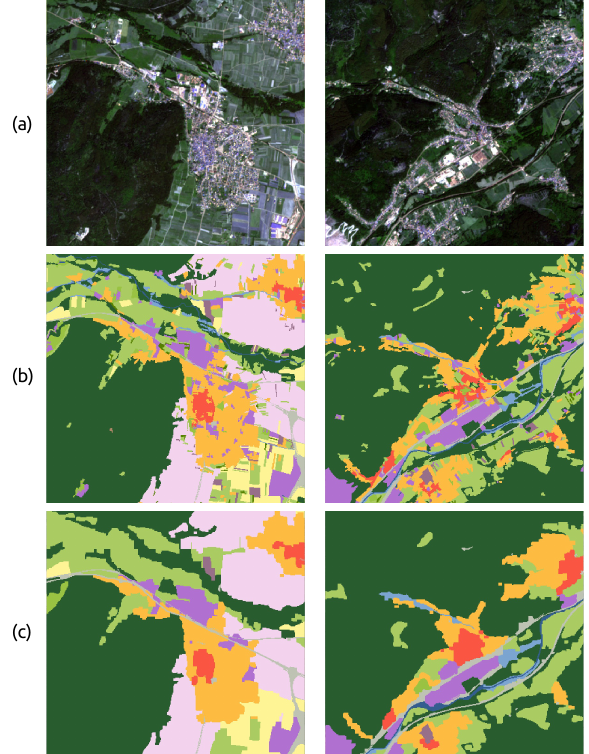
Figure 3. Comparison between (a) Sentinel-2 image in RGB, (b) reference database before the application of the connected components method and the (c) final reference data (Color legend like in Figure